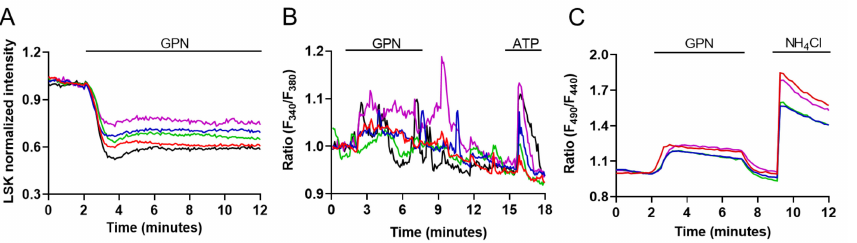
Figure 2. GPN evokes lysosomal Ca 2+ signaling events and cytosolic alkalization in M1 cells. ( A ) Effect of the lysosomotropic agent GPN (200 µ M) on the endo-lysosomal accumulation of LSK in M1 cells ( n = 89/89 responsive cells, m = 4 experiments); ( B ) Measurements of cytosolic Ca 2+ in response to both 200 µ M GPN and 100 µ M ATP in Fura-2-loaded M1 cells ( n = 47/69 responsive cells, m = 3 experiments); ( C ) Cytosolic pH measurement in response to 200 µ M GPN and 30 mM NH 4 Cl used as internal positive control in BCECF-loaded M1 cells ( n = 91/91 responsive cells, m = 3 experiments). All graphs show 5 representative traces for each experiment. Each color line represents an individual